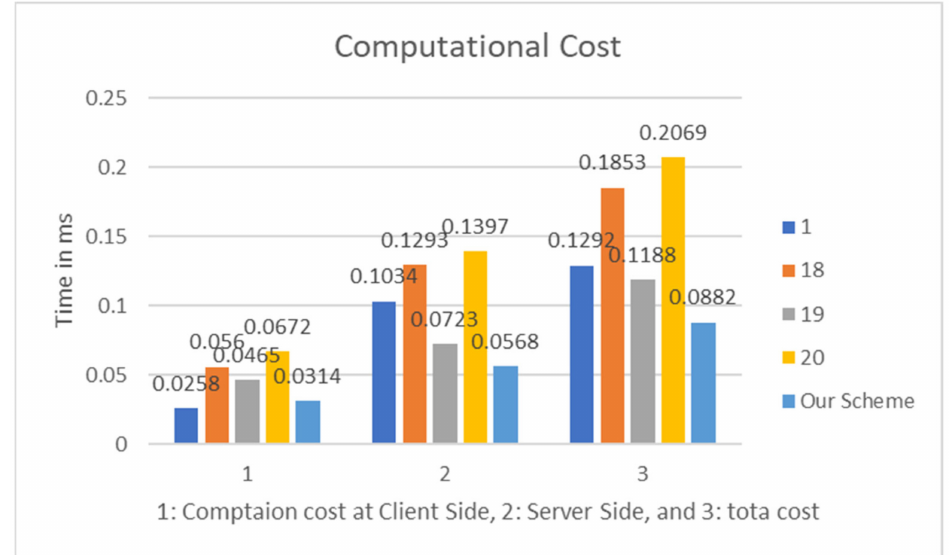
Figure 4. Computational